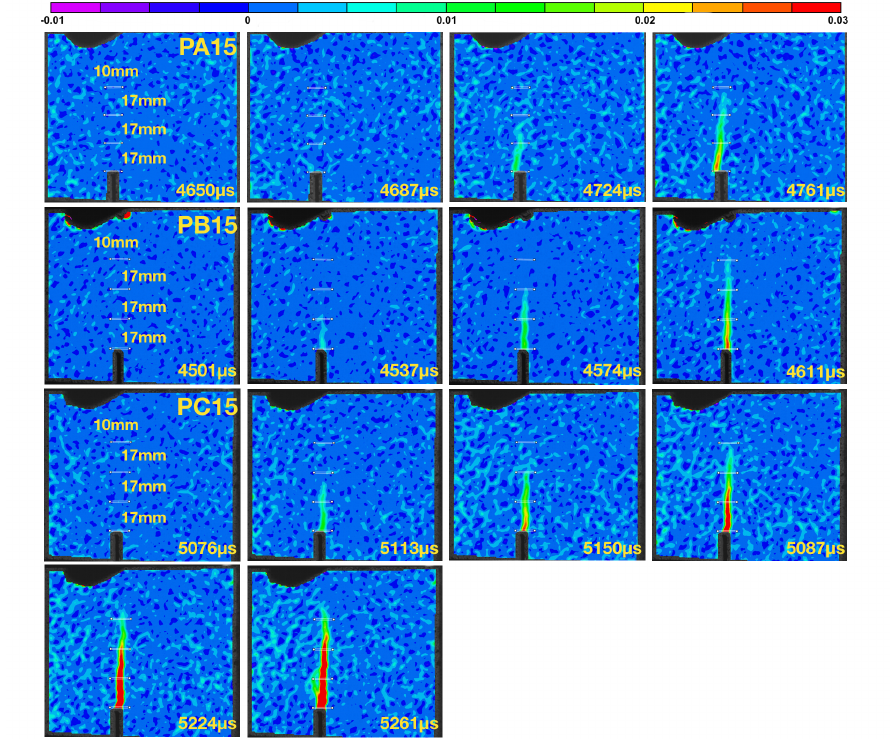
Figure 14. The crack propagation captured using a high-speed camera and processed using a DIC software as strain contours for the specimens PA15, PB15 and PC15 impacted at 2.66